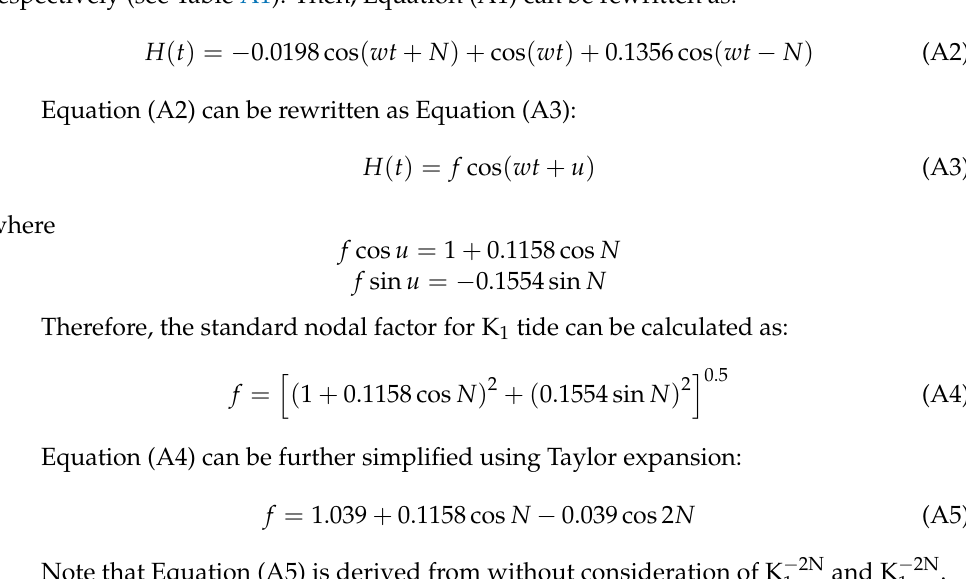
Table A1. Constituents near K1 tide. Their frequency, Doodson numbers, and theoretical amplitude ratios are listed. The theoretical values for K N Tidal